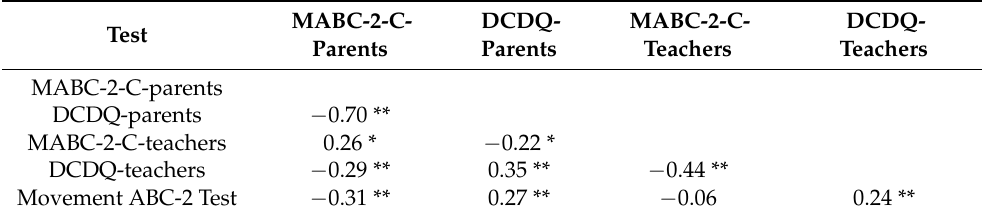
Table 6. Correlation of Movement ABC-2 Test and the MABC-2-C and DCDQ scores completed by parents and teachers of children with suspected DCD ( n = 172).